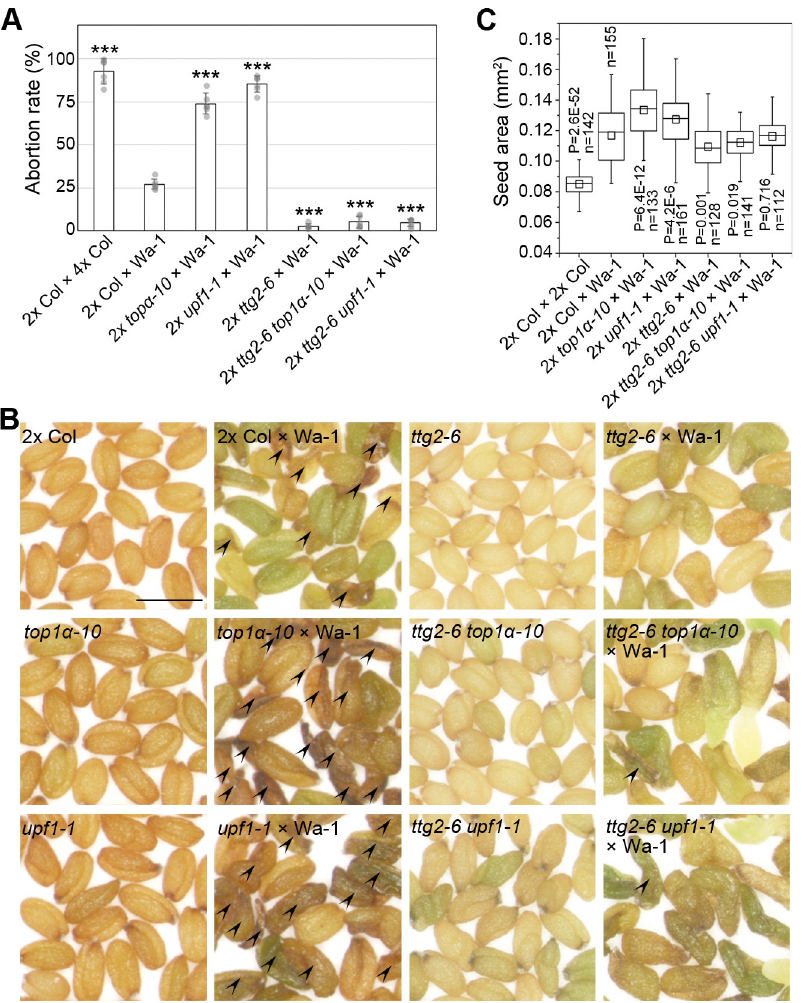
Fig 5. TOP1 α , UPF1 , and TTG2 affect the phenotypes of paternal-excess interploidy crosses. (A) Maternal mutations affect the abortion rate of paternal excess. Values are mean ± s.d. ��� P < 0.001 as compared to 2x Col × Wa- 1, two-tailed Student’s t test. (B) Seed morphology of paternal excess using Wa-1 and diploidy mutants. Arrowheads indicate the aborted seeds. Scale bar, 0.5 mm. (C) Maternal mutations affect the seed size of paternal excess. Aborted seeds are excluded before measurements. P values were determined by two-tailed Mann-Whitney U-test as compared to 2x Col × Wa-1. The data underlying this figure are included in S1 Data. n, number of seeds examined; Wa-1,